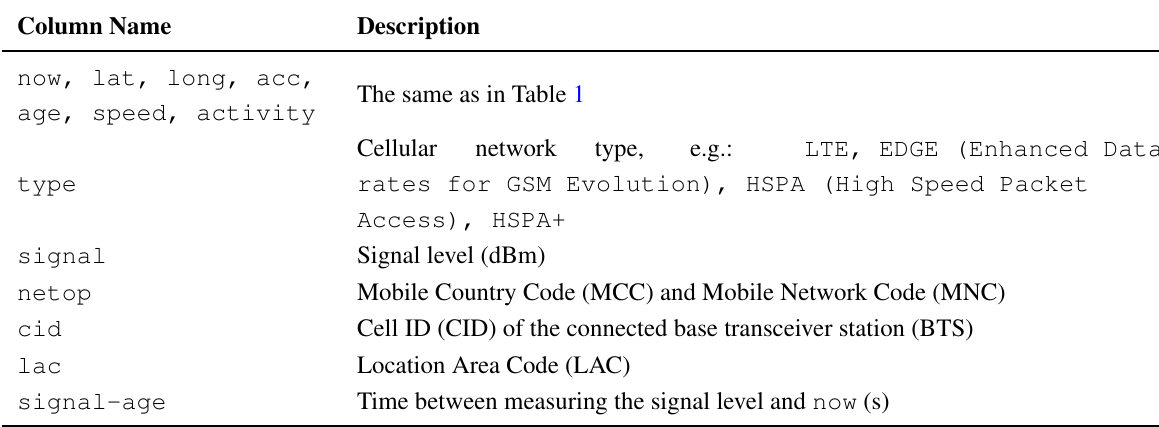
Table 2. Signal level data collected by BX